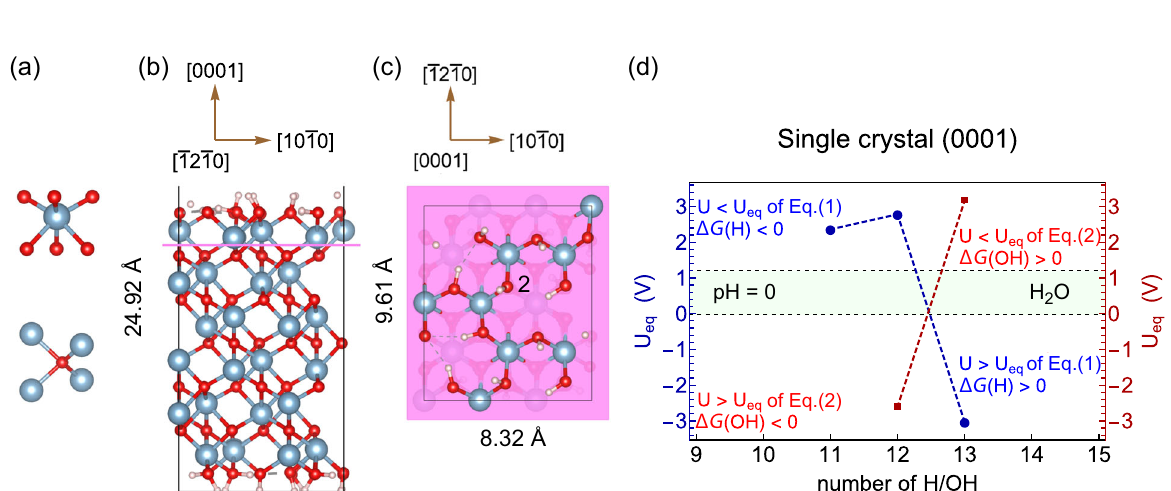
Fig. 2 The saturation of (0001) surface of single-crystal α – Al 2 O 3 . All atomistic structures in this paper were plotted using VESTA 55 . a Coordination numbers (CN) for Al (top sub fi gure) and O (bottom sub fi gure) in bulk α -Al 2 O 3 . Blue atoms are Al and red atoms are O. b Side view from the ½ 1210 (cid:3) direction of the supercell that is used to simulate (0001) surface of the single-crystal α -Al 2 O 3 . The vacuum region is not shown here. White atoms are H. c Top view of the supercell in b projected along [0001]. The translucent magenta plane divides the top surface layers and the bulk crystal. The location of this plane is also indicated by the horizontal magenta line in b . Each OH on the two (0001) surfaces at the top and bottom of the supercell has CN = 2. d The equilibrium electrode potential U eq of Eq. (1) and Eq. (2) on the (0001) surface of the supercell in b . The x -axis is the number of H/OH on the top (0001) surface of the supercell, which corresponds to the number l in Eq. (1) and Eq. (2). Blue and red data points are for U eq of Eq. (1) and Eq. (2), respectively, calculated from Eq. (3) and Eq. (5). Within the water stability region (light green region for U ∈ [0, 1.23] V relative to SHE.), it is thermodynamically unfavorable to add a 13th H/OH on the (0001) surface of the supercell in b .